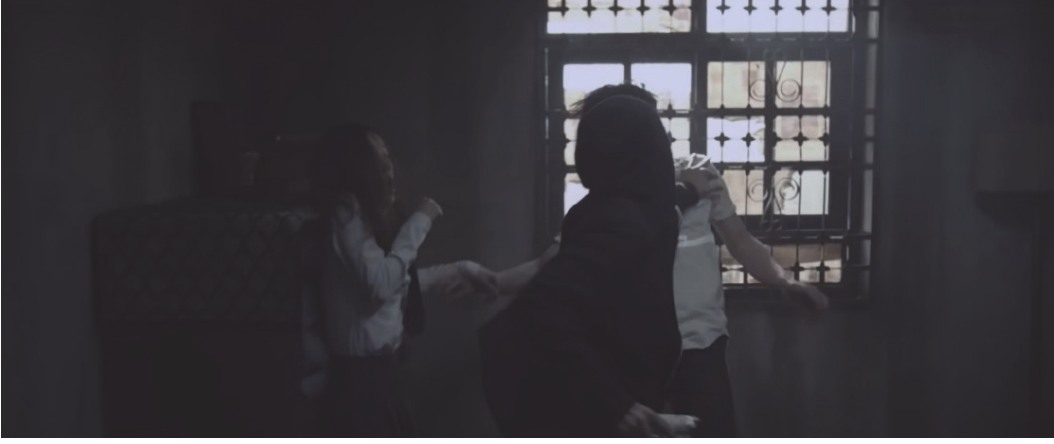
<Figure 7> Image of Domestic Abuse and Trauma in BTS. (2015a). “I NEED U” Official